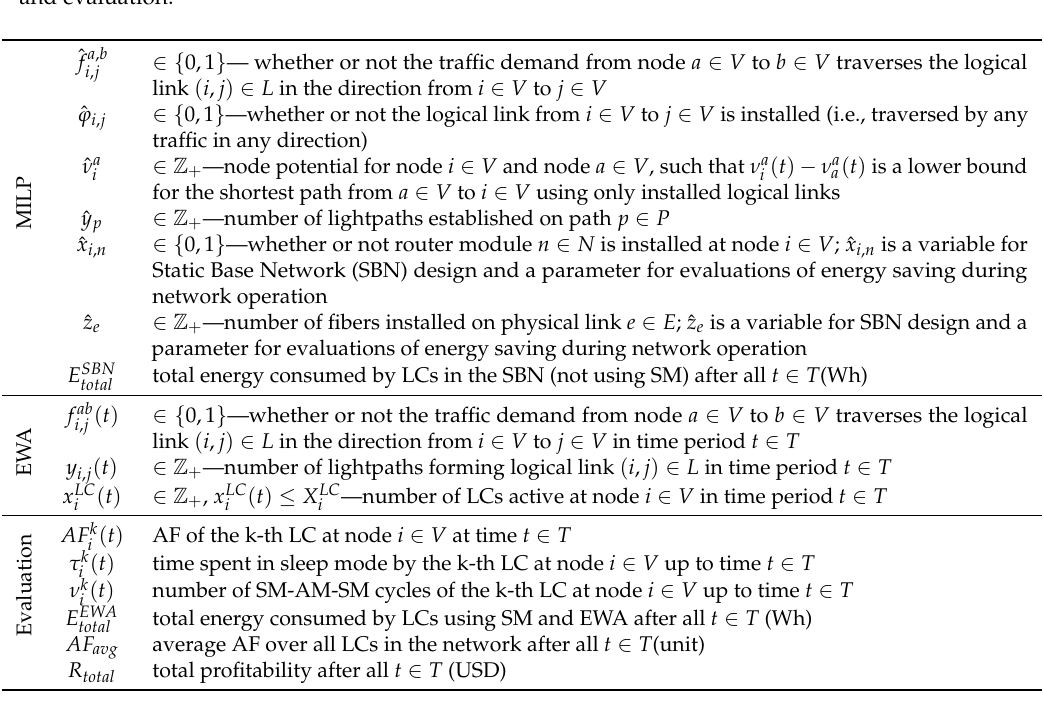
Table A3. Notation of variables used for network design (MILP), network operation (EWA), and